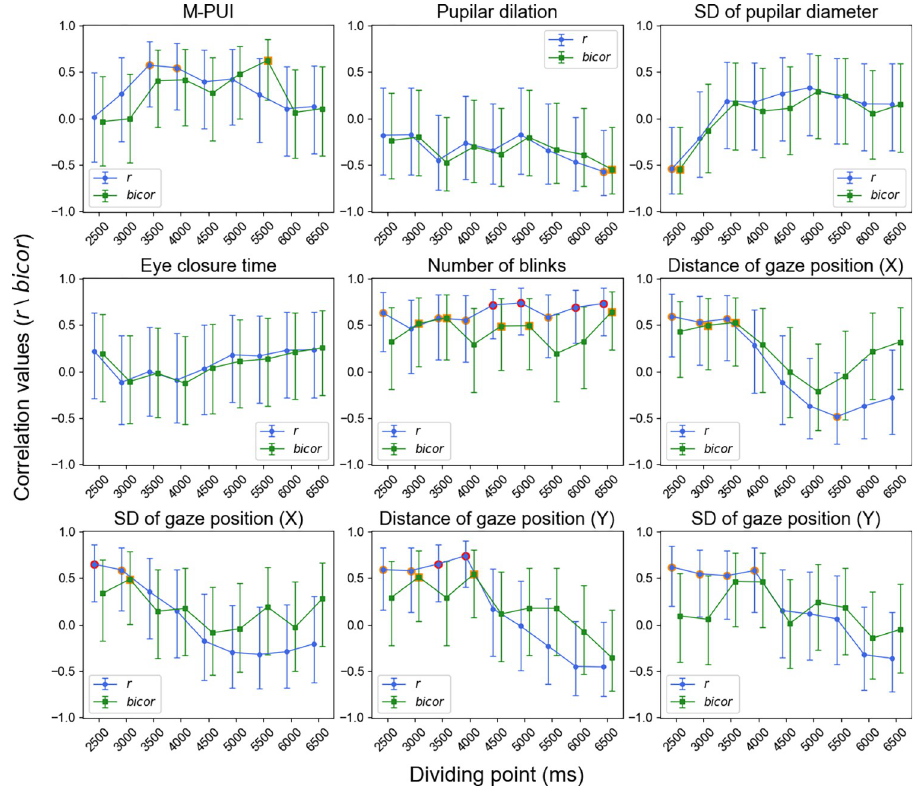
Fig 9. Dividing-point-dependent correlation of SE effect on RT for M-PUI and eye movement indices. The red circles indicate the dividing points that reached a corrected significance level of .0055. The orange circles indicate the dividing points that reached an uncorrected significance level of .05. Error bars represent 95% credible intervals.